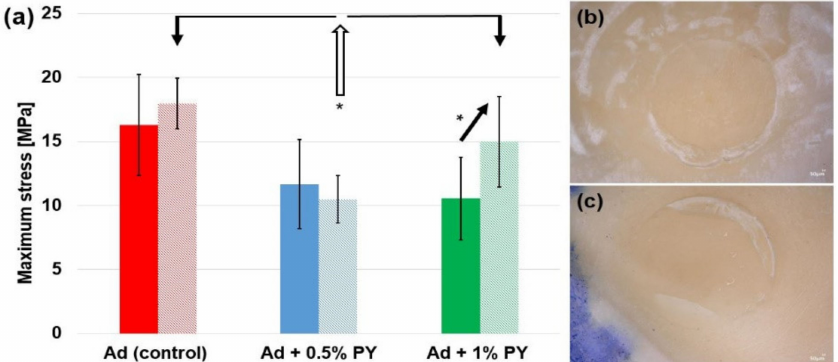
Figure 5. ( a ) Evolution of the bond strength for the universal adhesive (Ad “control”) and the universal adhesive modified with 0.5% (Ad + 0.5% PY) and 1% PY (Ad + 1% PY) at 24 h (dark-colored bars) and 6 months (slightly colored bars). (* p < 0.05). ( b , c ) Representative images obtained with an optical microscope ( × 50 magnification): ( b ) adhesive failure and ( c ) mixed failure.